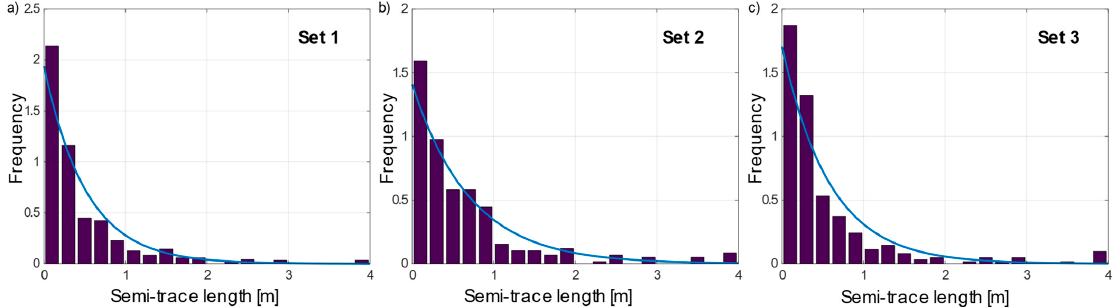
Figure 6. Frequency histogram versus semi-trace lengths with fitted negative exponential probabil- ity density distribution (blue line): ( a ) set 1 μ L = 0.515 m, ( b ) set 2 μ L = 0.710 m, and ( c ) set 3 μ L = 0.587